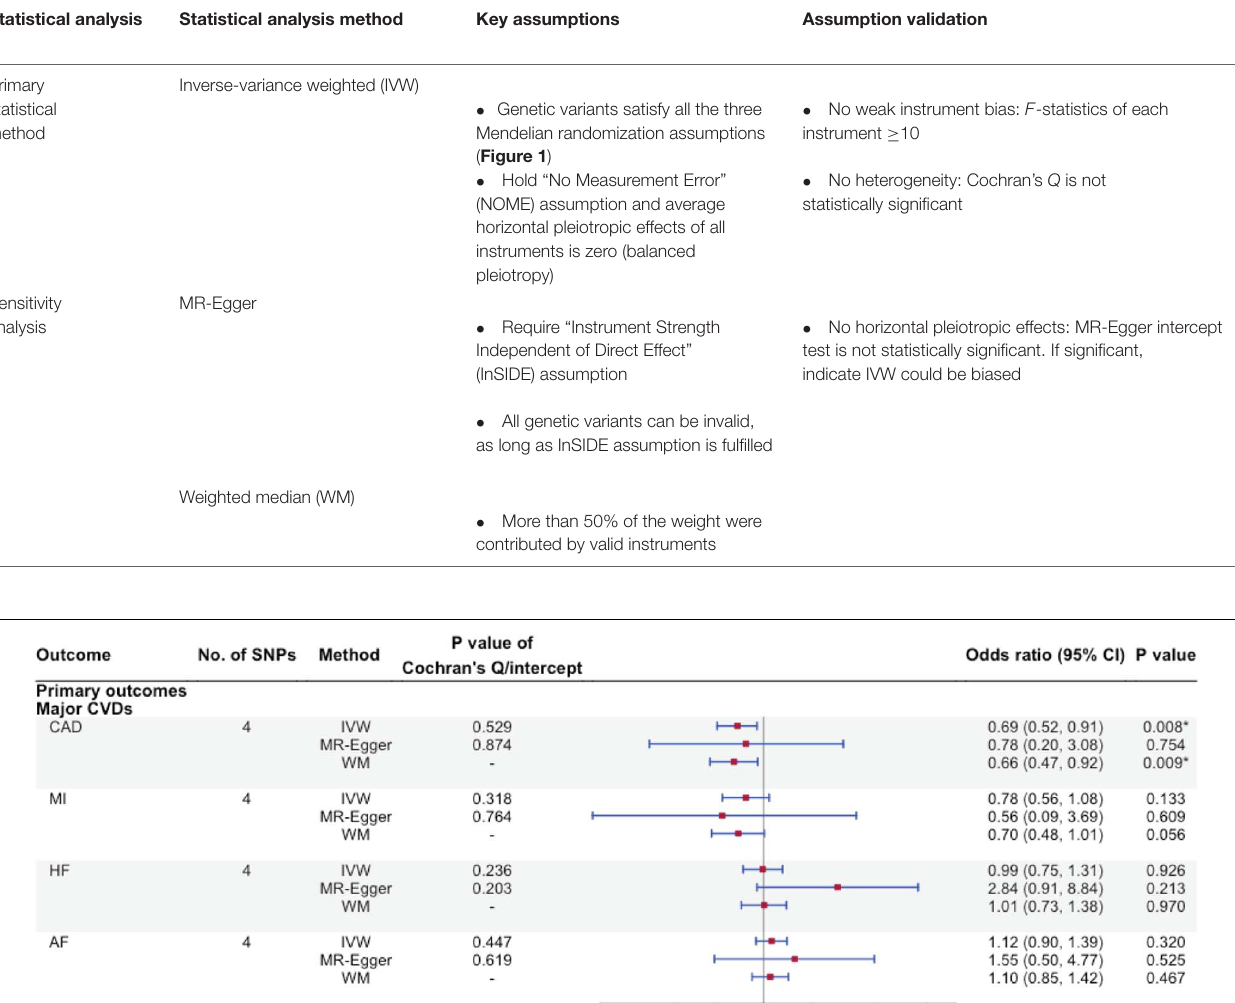
TABLE 2 | Details of statistical analysis methods used in this Mendelian randomization study.